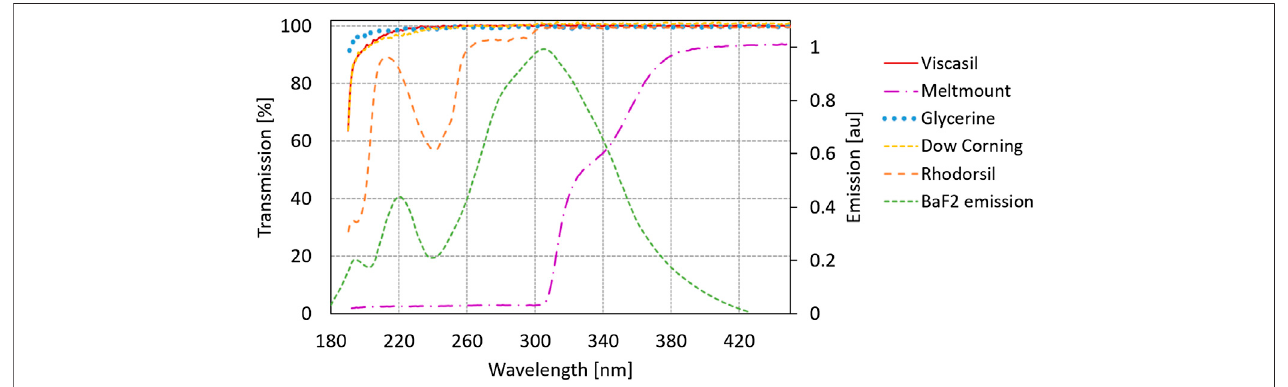
FIGURE 5 | Transmission measurements of several optical couplings agents between two quartz plates, performed between 190 and 440 nm, corrected for the absorption by one quartz plate and the Fresnel re fl ection between the quartz/air interfaces. Also the emission spectrum of BaF 2 has been plotted for comparison [22].